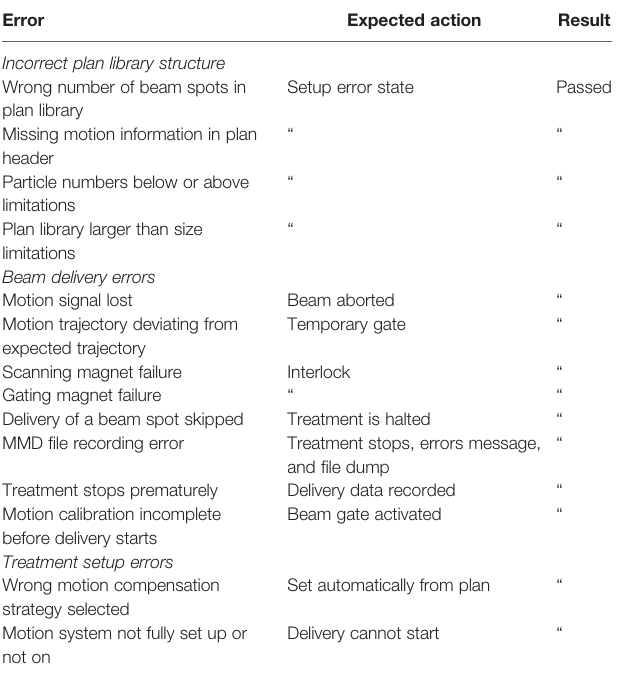
TABLE 4 | Summary of pass-fail tests and results.